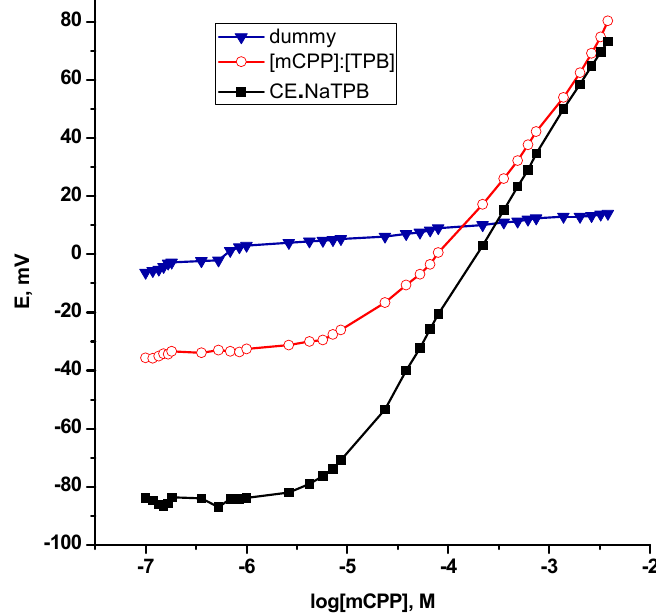
Figure 2. Calibration plots of ion exchanger and ionophore polymeric membrane based selective sensors for mCPP.